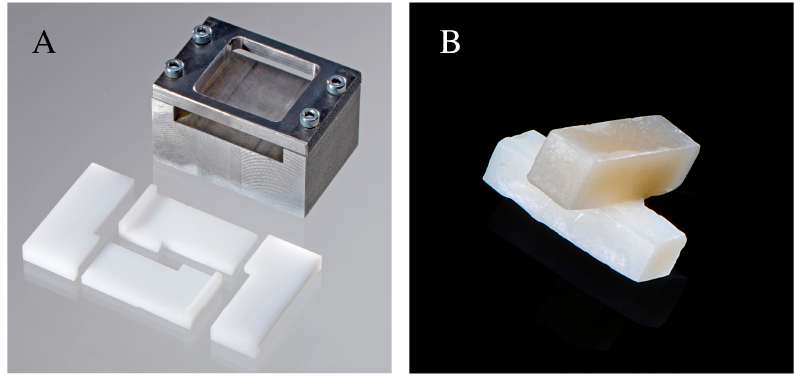
Figure 2. ( A ) Polyacetal Delrin molds used to produce the composite samples; ( B ) Bonded